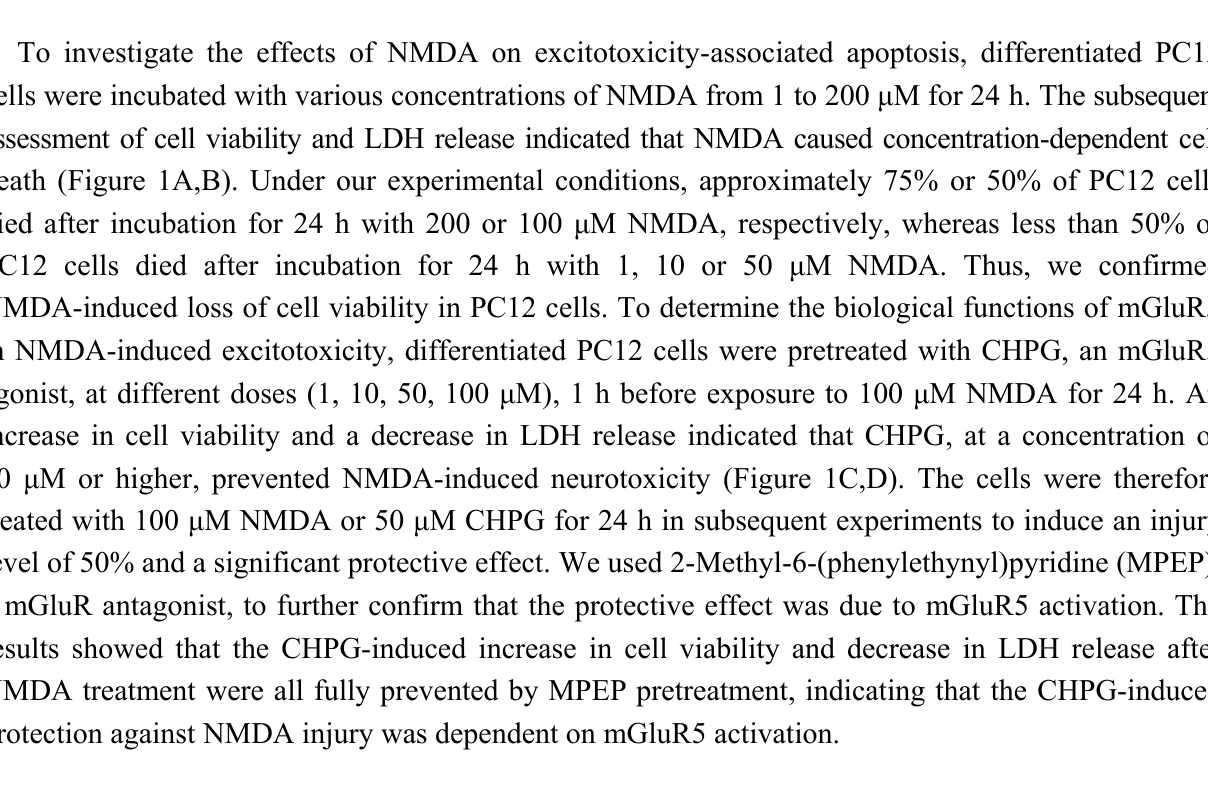
Figure 1. CHPG ( R , S -2-chloro-5-hydroxyphenylglycine) protects against NMDA ( N -methyl- D -aspartate)-induced neurotoxicity. Differentiated PC12 cells were treated with NMDA at different concentrations (1, 10, 50, 100 or 200 μM) for 24 h, and cell viability ( A ) and LDH (lactate dehydrogenase) release ( B ) were assayed, respectively; ( C , D ) Cells were pretreated with CHPG at varying doses (1, 10, 50 or 100 μM) 1 h before exposure to 100 μM NMDA for 24 h, and cell viability and LDH release were assayed subsequently; ( E , F ) Cells were pretreated with CHPG (50 μM), 1 h before NMDA treatment with or without 2-Methyl-6-(phenylethynyl)pyridine (MPEP) (20 μM), and cell viability and LDH release were assayed subsequently. Data are represented as means ± SD from six experiments. * p < 0.05 vs. control group and # p < 0.05 vs. cells treated only with NMDA. & p <